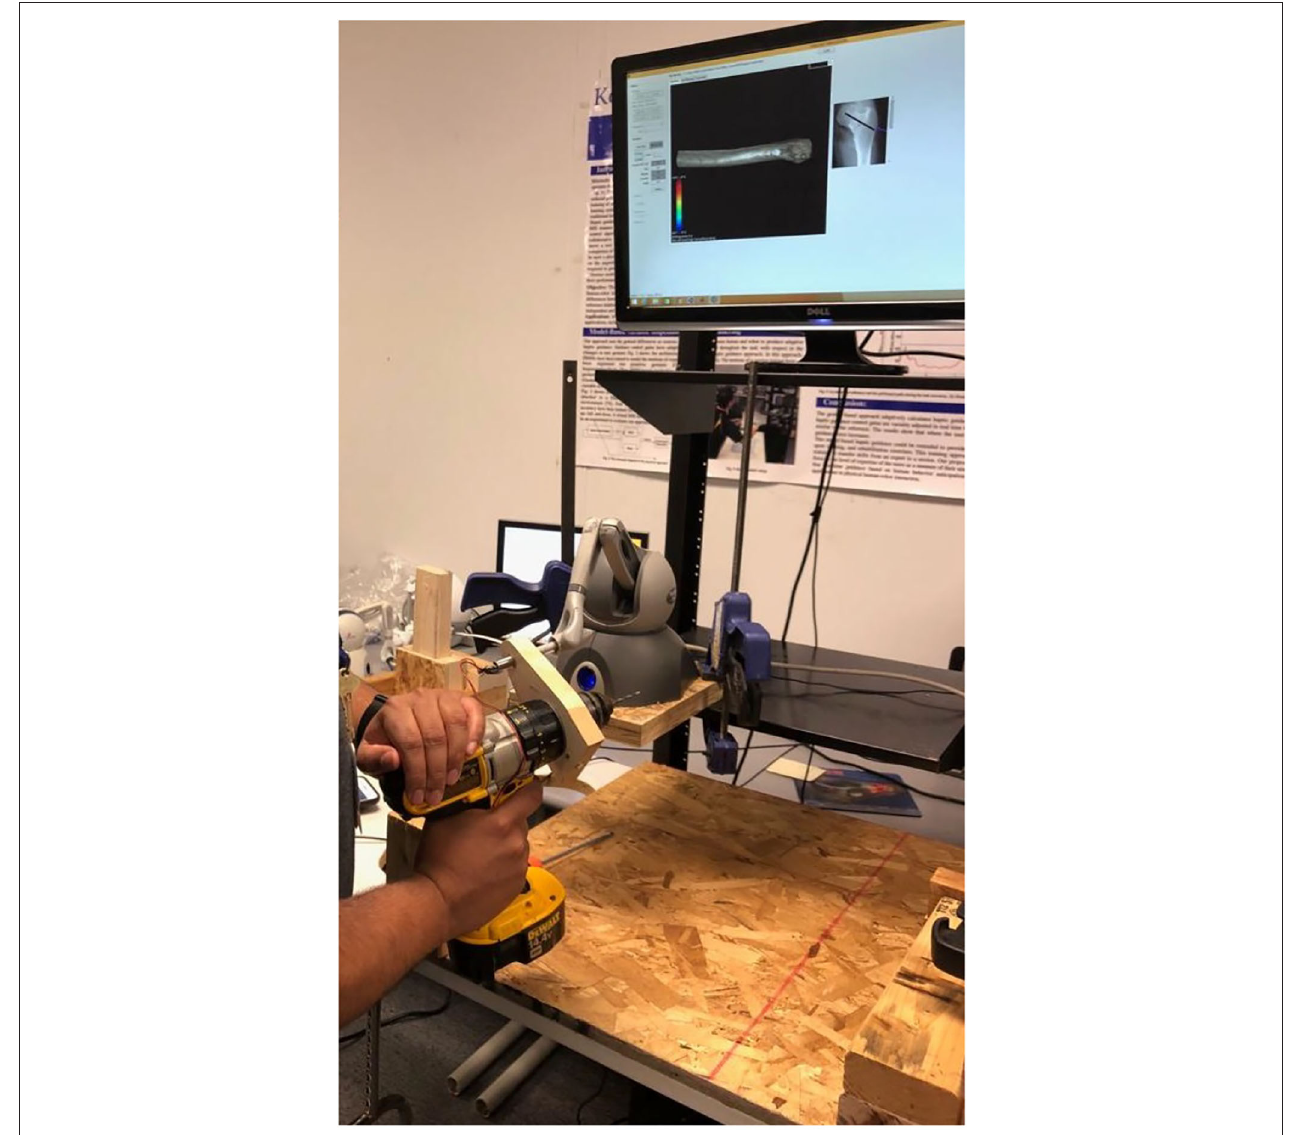
FIGURE 2 | Experimental setup: A volunteer is completing a required surgical drilling task while using a drill attached to the haptic device. It encompasses a haptic device, a keyboard, and a computer mouse interacting with a simulation.